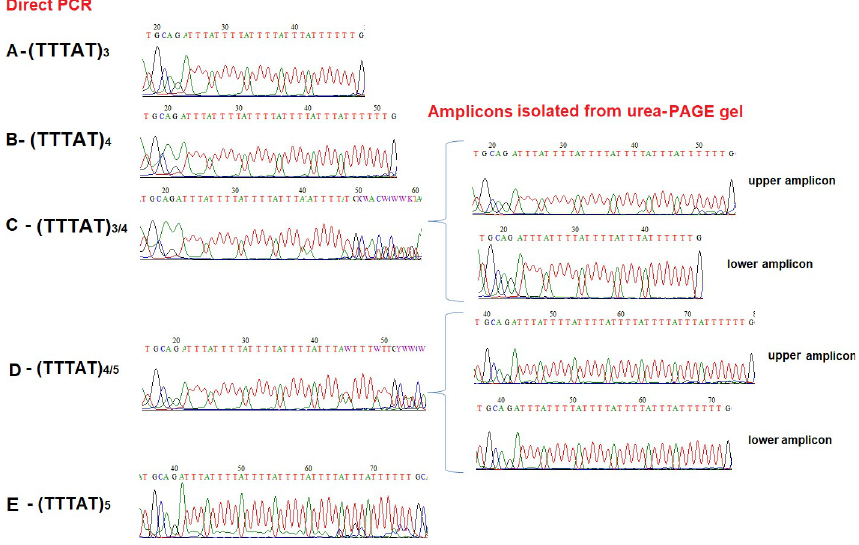
Fig 2. The sequencing results for the (TTTAT) 3-5 microsatellite polymorphism in the LDHA gene. A. (TTTAT) 3 /(TTTAT) 3 homozygote. B. (TTTAT) 4 /(TTTAT) 4 homozygote. C. (TTTAT) 3 /(TTTAT) 4 heterozygote. D. (TTTAT) 4 /(TTTAT) 5 heterozygote. E. (TTTAT) 5 /(TTTAT) 5